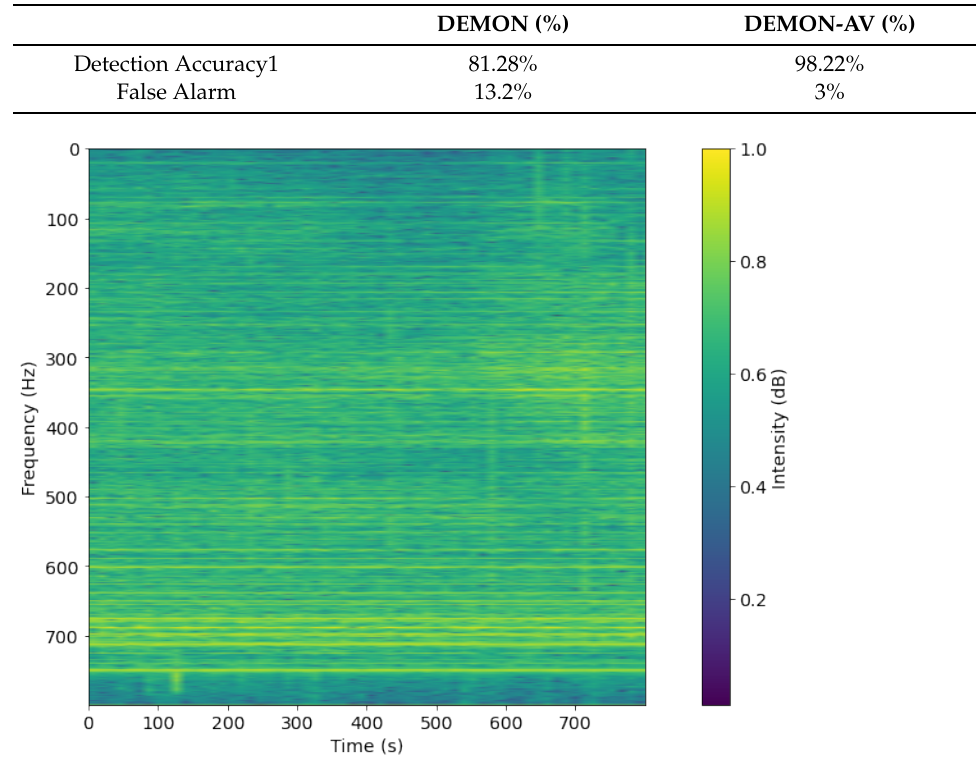
Figure 8. Spectrogram after pre-processing with DEMON-AV for